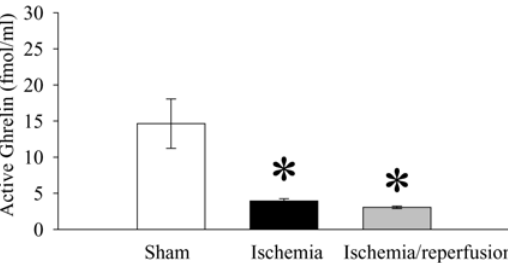
Figure 1. Alterations in plasma levels of ghrelin at the end of 90-min gut ischemia (Ischemia), 2 h reperfusion after ischemia (Ischemia/reperfusion), or sham operation (Sham). Data are presented as means 6 SE (n=5–6) and compared by one-way ANOVA and Student-Newman-Keuls test: * P , 0.05 versus Sham group.